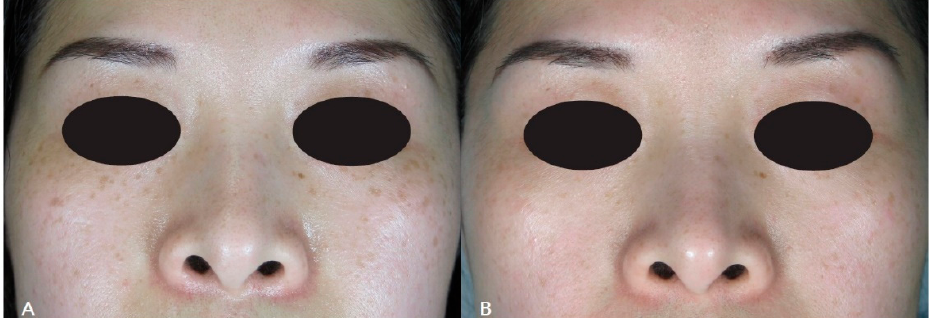
Figure 1. Patient 18 before ( A ) and after treatments ( B ).